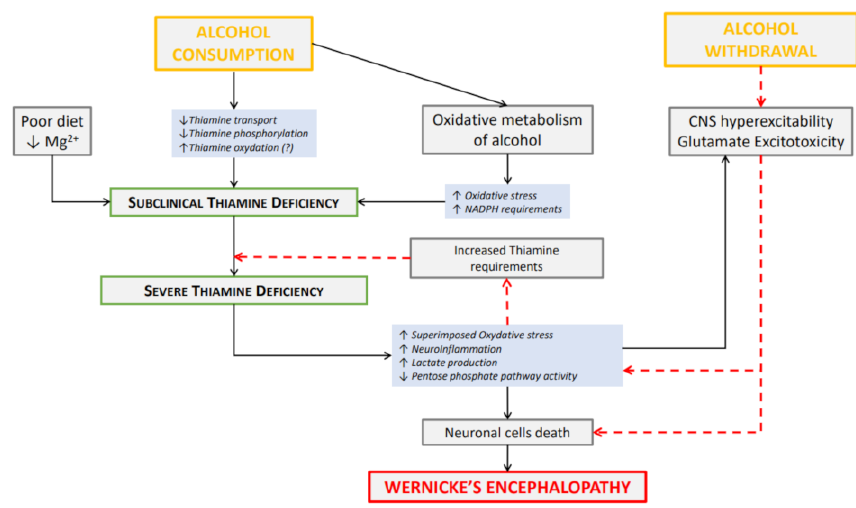
Figure 1. Relationships between alcohol consumption, alcohol withdrawal and Wernicke’s en- cephalopathy. Alcohol consumption may be responsible for subclinical thiamine deficiency due to elevated thiamine requirements for energy metabolism and oxidative alcohol metabolism, impaired thiamine distribution and metabolism, and impaired nutritional status. Red dotted arrows indicate the effect of alcohol withdrawal that induces central nervous system (CNS) hyperexcitability, gluta- mate excitotoxicity, and exacerbates oxidative stress, neuroinflammation and thiamine requirements leading in some cases to severe thiamine deficiency, synchronous neuronal cell death, including localized thalamic and mamillary bodies neuron death responsible for Wernicke’s encephalopathy. The «(?)» corresponds to a